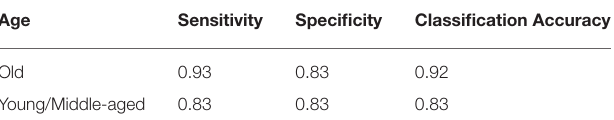
Age Sensitivity